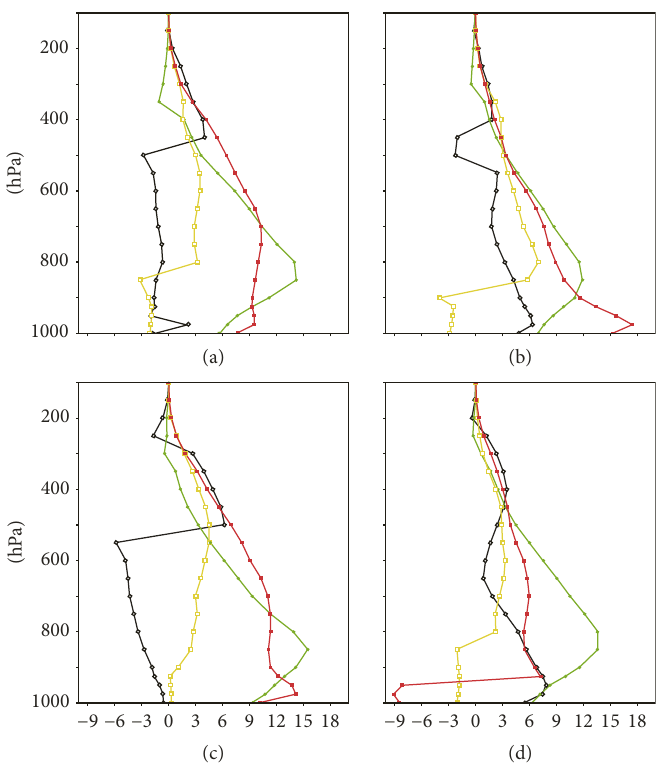
Figure 9: Vertical distribution of averaged water vapor flux from the east boundary (red line), south boundary (green line), west boundary (yellow line), and north boundary (black line) during the SFP (a), SHEP (b), NCVP (c) LLSVSP and (d) rainstorm cases (unit: g · cm − 1 · hPa − 1 · s − 1